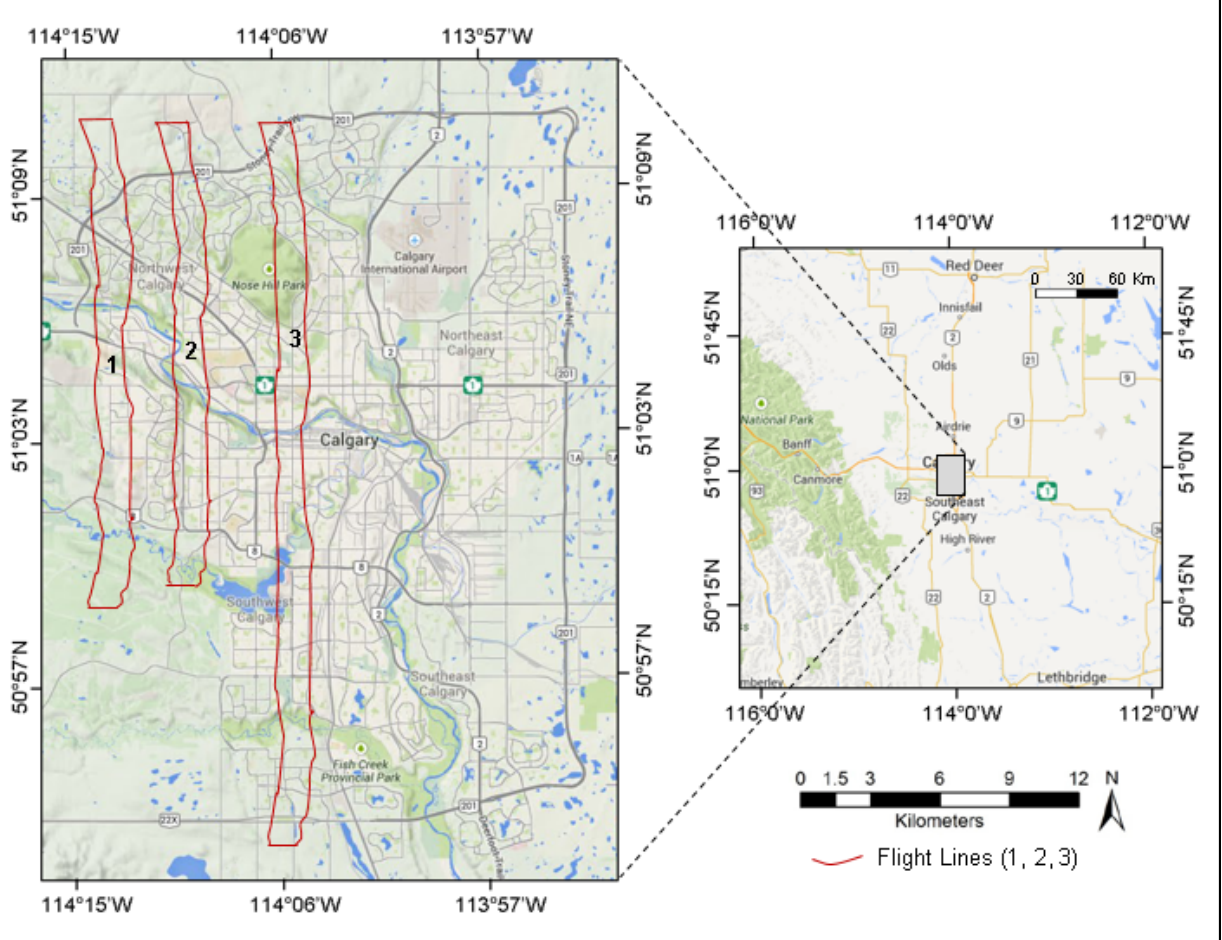
Figure 1. A map of The City of Calgary showing the location of the three flight-lines evaluated in this